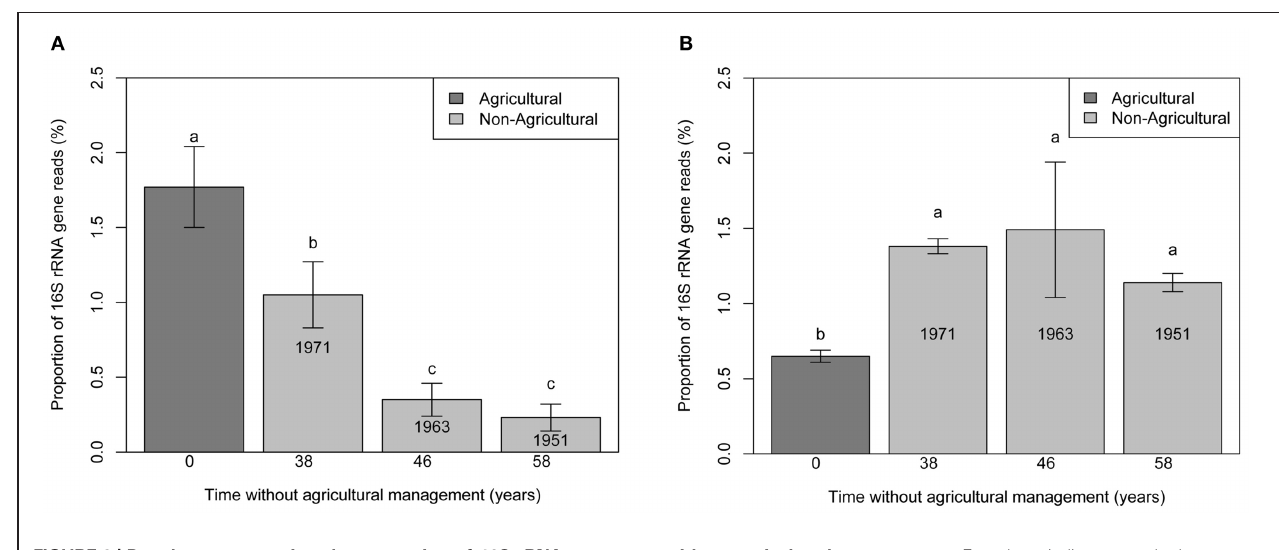
FIGURE 3 | Bar chart representing the proportion of 16S rRNA gene reads for Ca. Nitrososphaera (A) and Bradyrhizobium (B) at the Kellogg Biological Station (KBS) site at agricultural plots, and plots